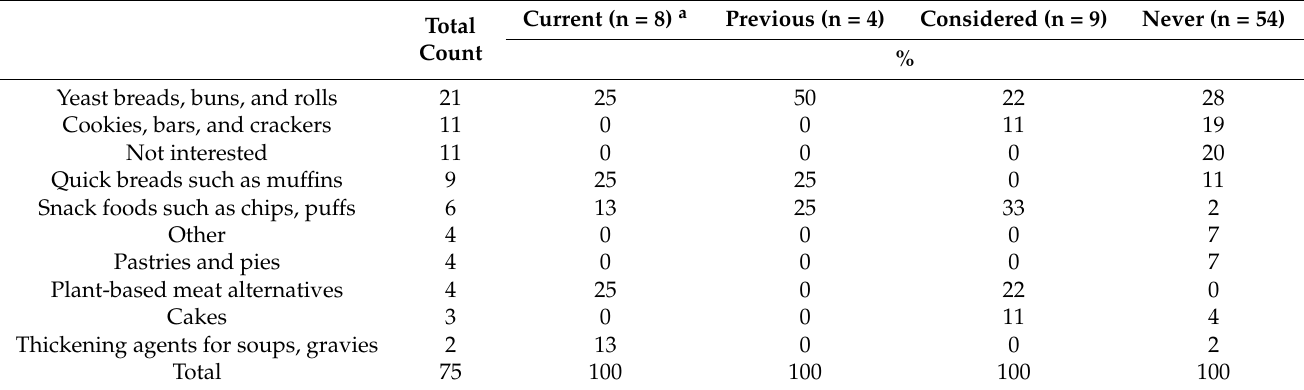
Table 3. Participants’ interest in food product type by user category.